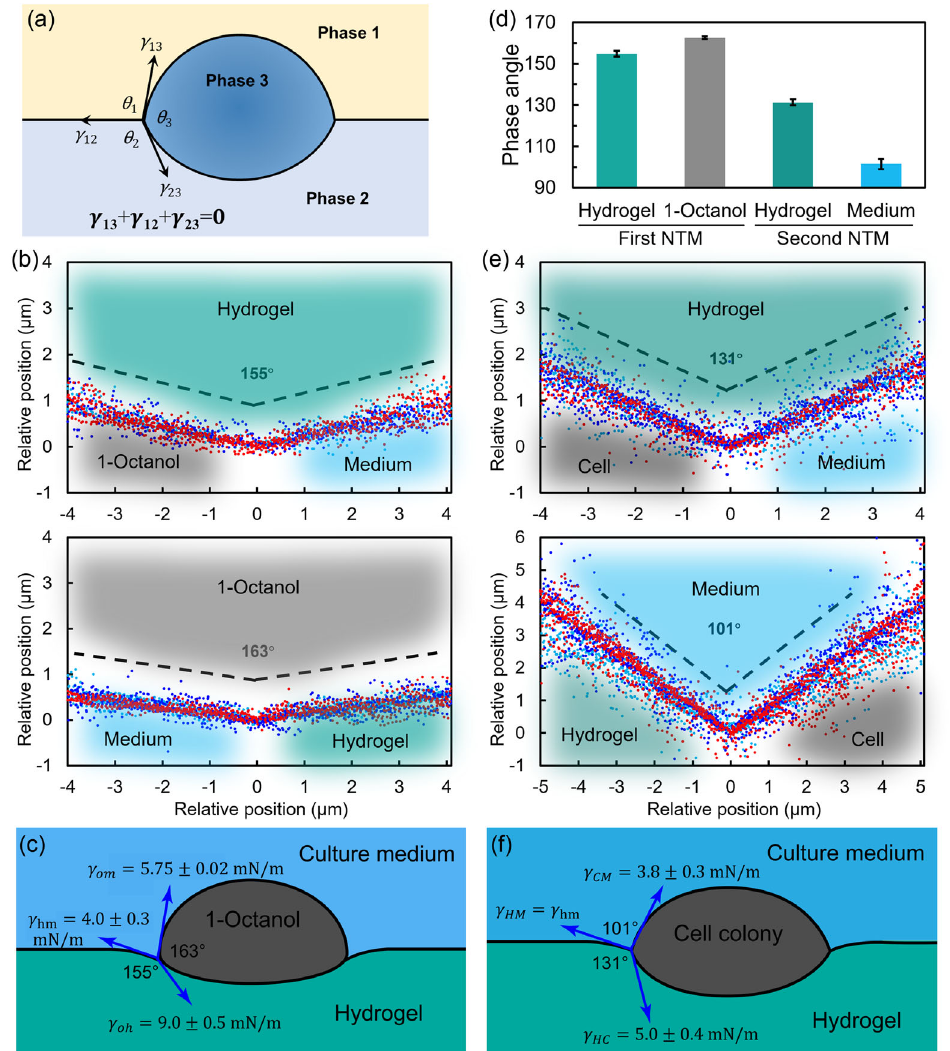
FIG. 3. Measurement of interfacial stresses by NTM. (a) Diagram of the Neumann ’ s triangle. (b) Determination of the hydrogel and 1-octanol phase angles by the plotted phase boundary profiles, in the octanol-medium-hydrogel phase system. For each phase angle, a total of 50 cross-section images from three independent 1-octanol droplets are analyzed. Each chart contains randomly chosen 33 boundary profiles, which are rotated and shifted to align the cusp regions. Each color of the dots resembles the boundary profiles from one droplet. (c) Determination of the interfacial stresses from the phase angles based on the Neumann ’ s triangle scheme. (d) Average phase angles summarized from the plotted phase boundary profiles in the first ( n ¼ 50 ) and second ( n ¼ 45 ) NTM. Error bars denote standard error of the mean. (e) Determination of the medium and hydrogel phase angles by the plotted phase boundary profiles, in the cell-medium-hydrogel phase system. For each phase angle, a total of 45 cross-section images with three independent cell colonies are analyzed. Each chart contains randomly chosen 33 boundary profiles, which are rotated and shifted to align the cusp regions. Each color of the dots resembles the boundary profiles from one colony. (f) Determination of the interfacial stresses from the phase angles based on the Neumann ’ s